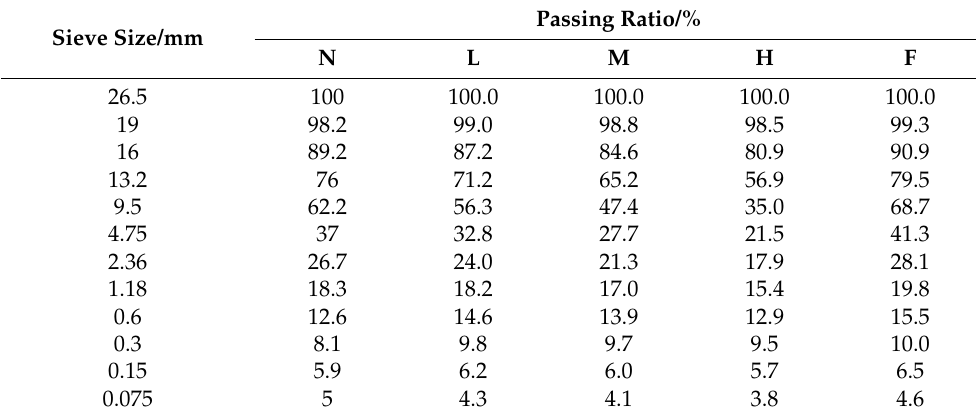
Table 1. Gradation composition of AC-20 segregated mixture.